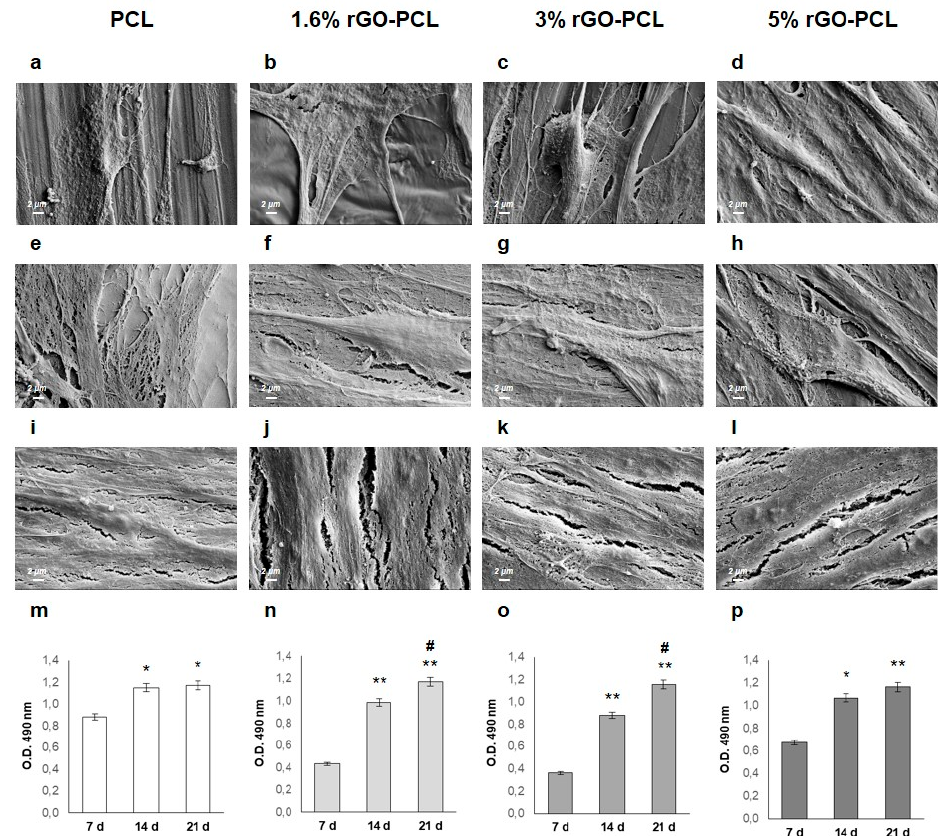
Figure 4. Adhesion and proliferation of HMSCs on rGO-PCL surfaces in osteogenic differentiation medium. SEM images (5 ox magnification) after 7 ( a – d ), 14 ( e – h ), and 21 days ( i – l ) of culture. MTS assay at 7, 14, and 21 day ( m – p ). Data are expressed as mean ± SD. Multi comparison statistical analysis were performed by using one-way ANOVA. T test was to perform all pairwise comparisons between group means. Note: * p < 0.05 and ** p < 0.01 mark significant changes compared to 7 days of culture. # p < 0.05 marks significant changes compared to 14 days of culture.